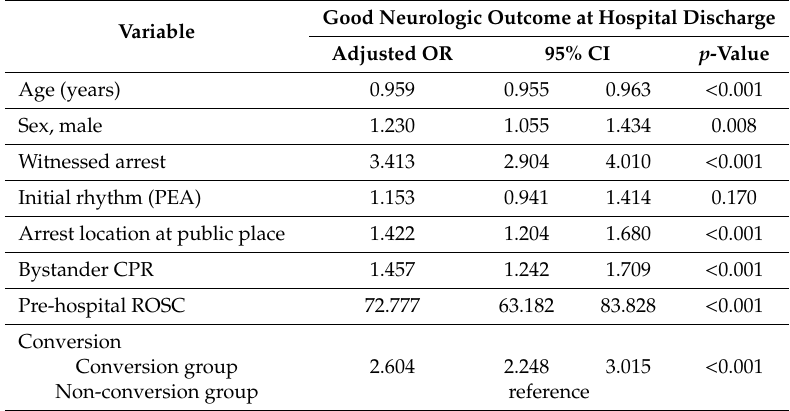
Table 2. Multiple logistic regression analysis for good neurologic outcome at hospital discharge.